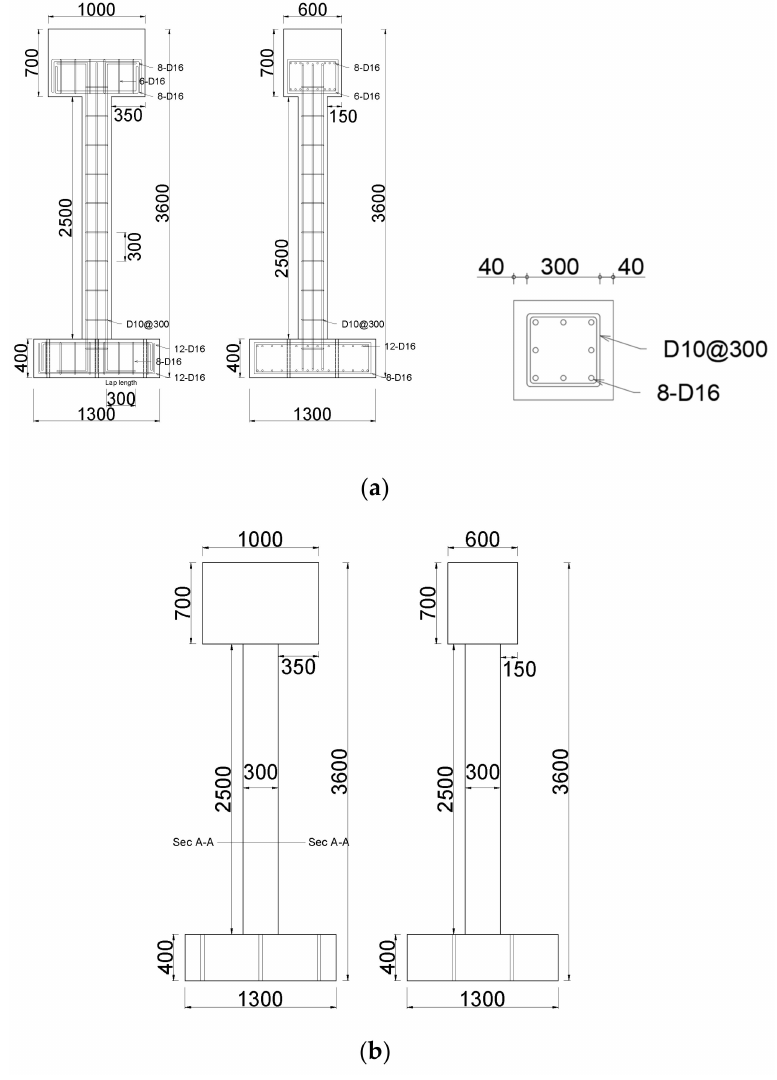
Figure 7. Details of the specimen reinforcement: ( a ) reinforcement details of the specimen and the ( b ) details of the specimen holes (unit: